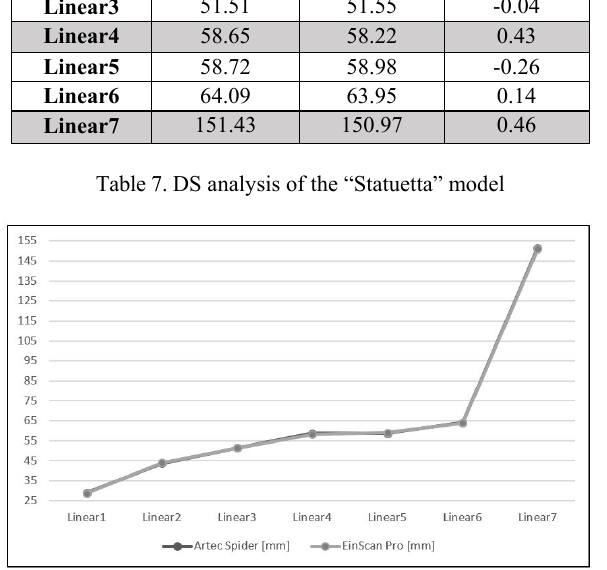
Figure 9. Graph of the analysis DS of the “Statuette” model